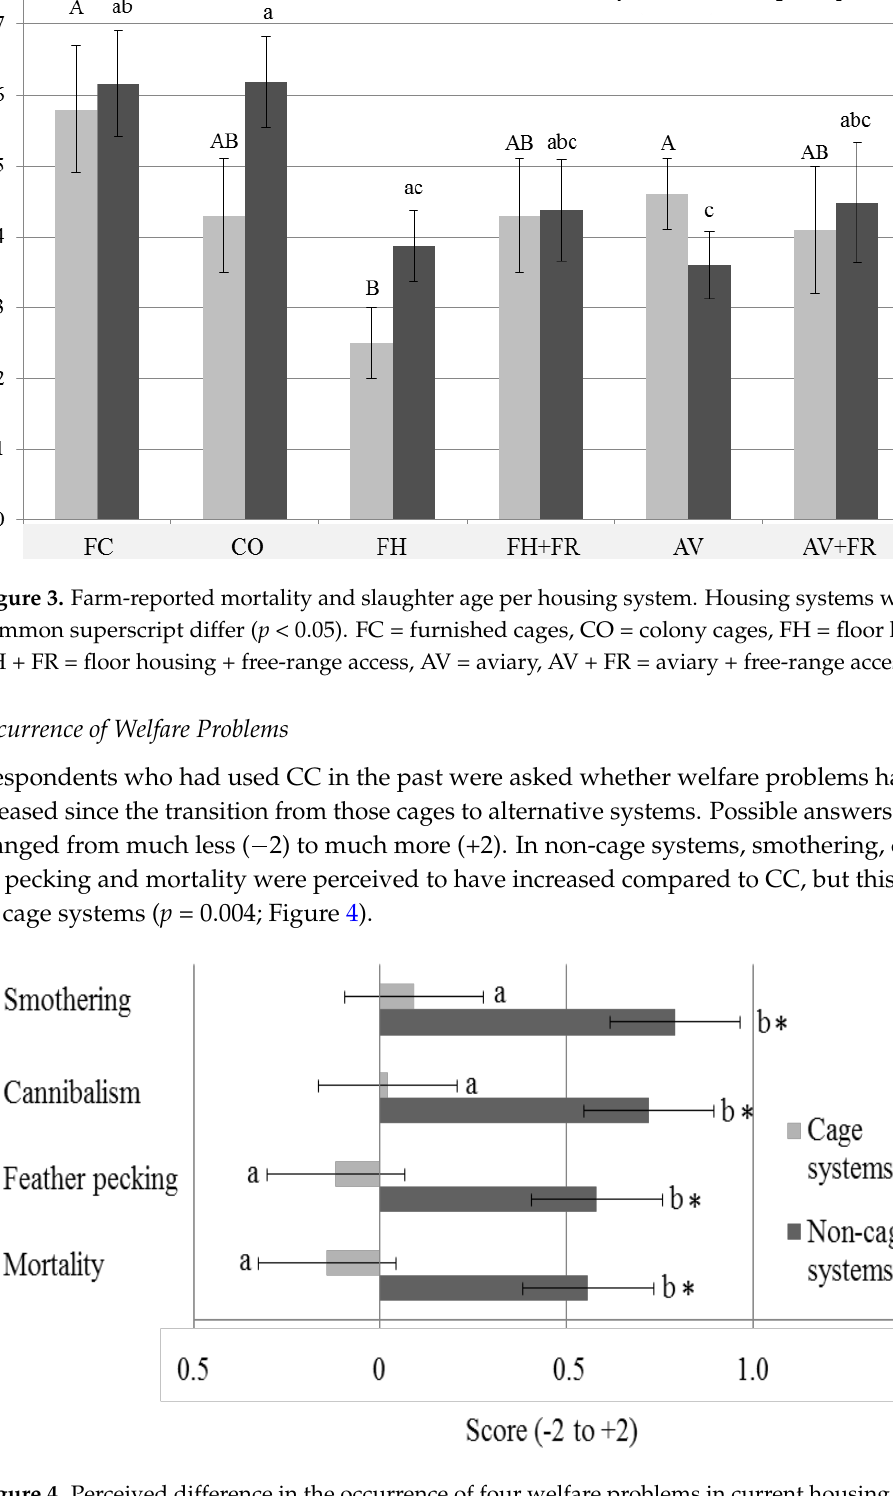
Figure 4. Perceived difference in the occurrence of four welfare problems in current housing systems compared to conventional cages, grouped by farmers with only cage (n = 20) or only non-cage (n = 23) systems. Lack of a common letter next to the bar indicates a difference in opinion ( p < 0.05) between farmers currently using cage vs. non-cage systems. Scores ranged from –2 (much less) to +2 (much more). Asterisks indicate a significant difference from the neutral score (0).